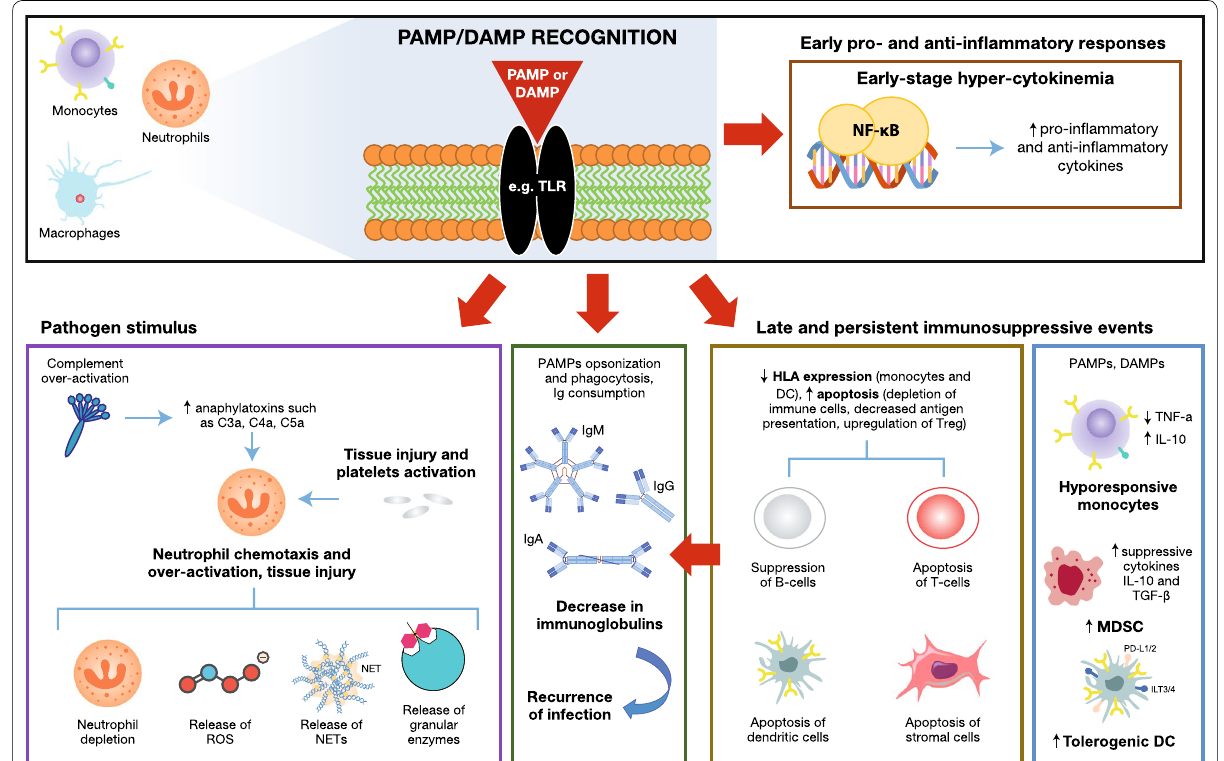
Fig. 1 Immune pathophysiology of sepsis. DAMP damage‑associated molecular pattern, DC dendritic cell, HLA human leukocyte antigen, IgM/G/A immunoglobulin M/G/A, IL interleukin, MDSC myeloid‑derived suppressor cell, NET neutrophil extracellular trap, NF-kB nuclear factor kappa‑light‑chain‑enhancer of activated B cells, PAMP pathogen‑associated molecular pattern, PD-1 programmed death protein 1, PD-L1 programmed death ligand 1, ROS reactive oxygen species, TGF-β transforming growth factor β, TLR toll‑like receptor, TNF-α tumor necrosis factor α, Treg regulatory T